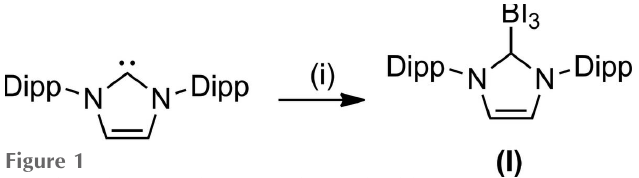
Table 2 Experimental details.